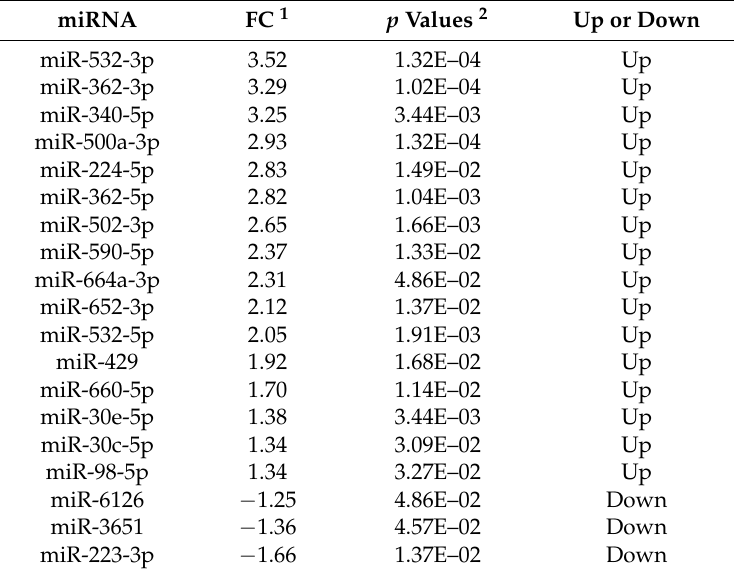
Table 2. Nineteen miRNAs that were differentially expressed in EGFR -mutated compared to EGFR wild-type lung